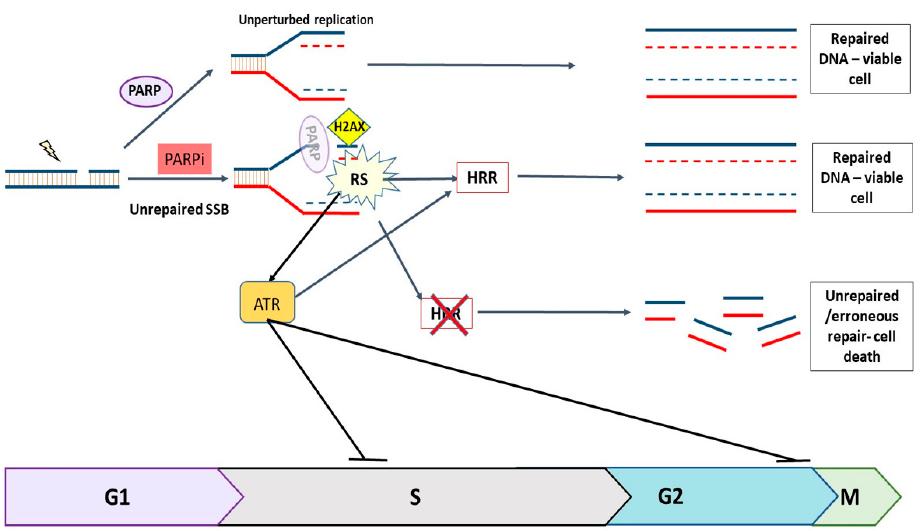
Figure 1. The role of PARP1 and PARP2 (PARP) and ATR in the DNA damage response. Endoge- nously generated SSBs are continuously repaired by PARP-dependent repair mechanisms. When PARP is inhibited, unrepaired SSBs collide with replication forks, causing them to stall and collapse, resulting in DSBs which can only be repaired by HRR during S and early G2 phases. If HRR is defective, e.g., due to a BRCA mutation, the DNA cannot be repaired accurately, resulting in cell death. Replication stress (RS) caused by PARPi activates ATR, which triggers a cascade that halts cell cycle progression and promotes HRR.